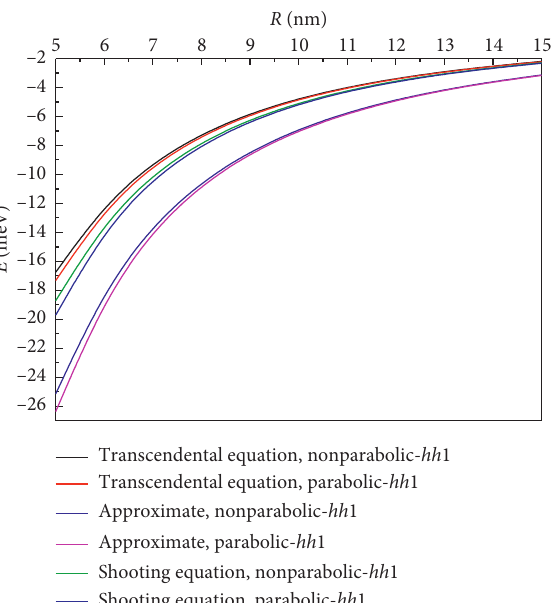
Figure 3: The dependence of the energy of a heavy hole on the radius of a cylindrical quantum wire for the parabolic and nonparabolic dispersion law.